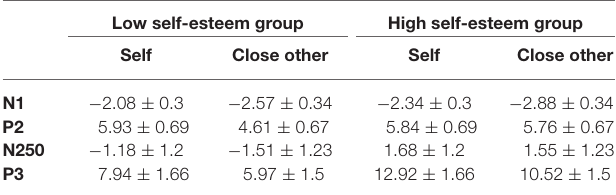
TABLE 1 | The amplitudes of N1, P2, N250 and P3 components in the self and close other conditions during low and high self-esteem groups ( µ V, M ± SE ).